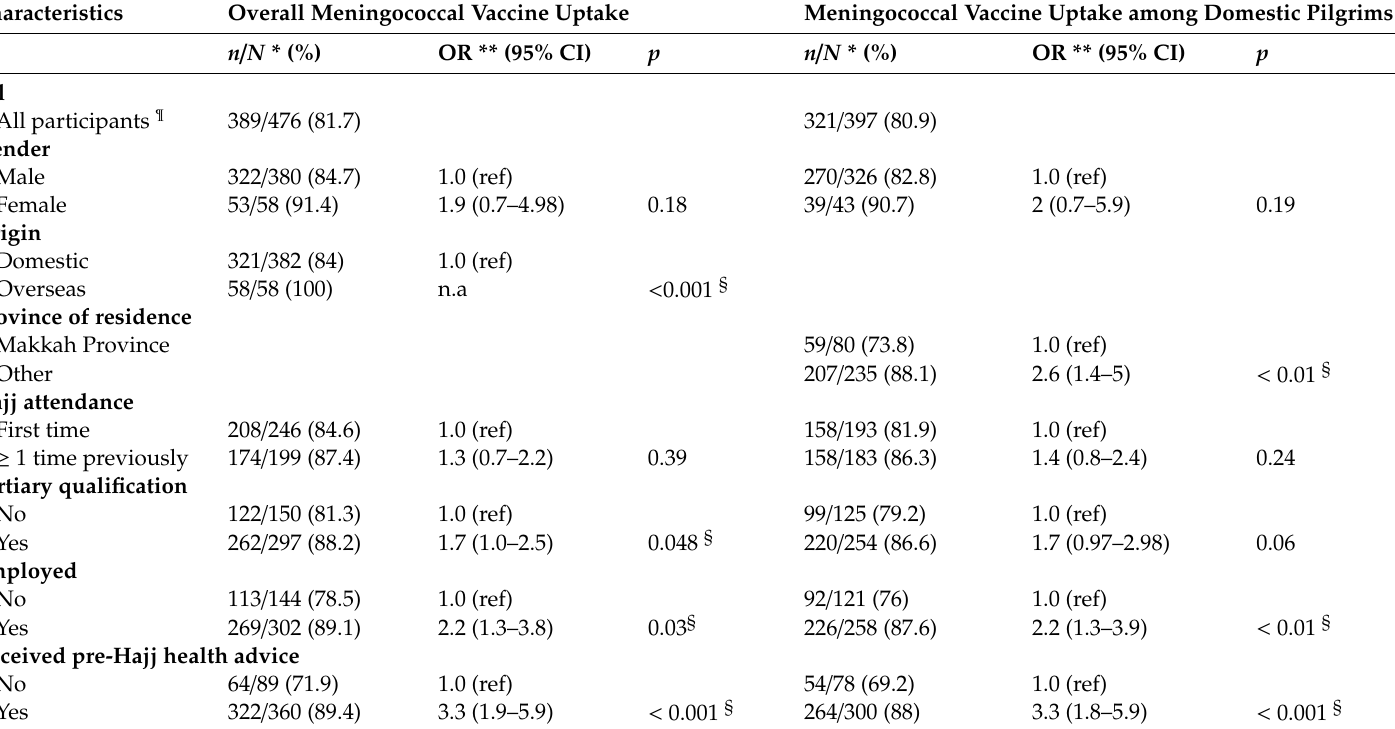
Table 3. Meningococcal vaccine